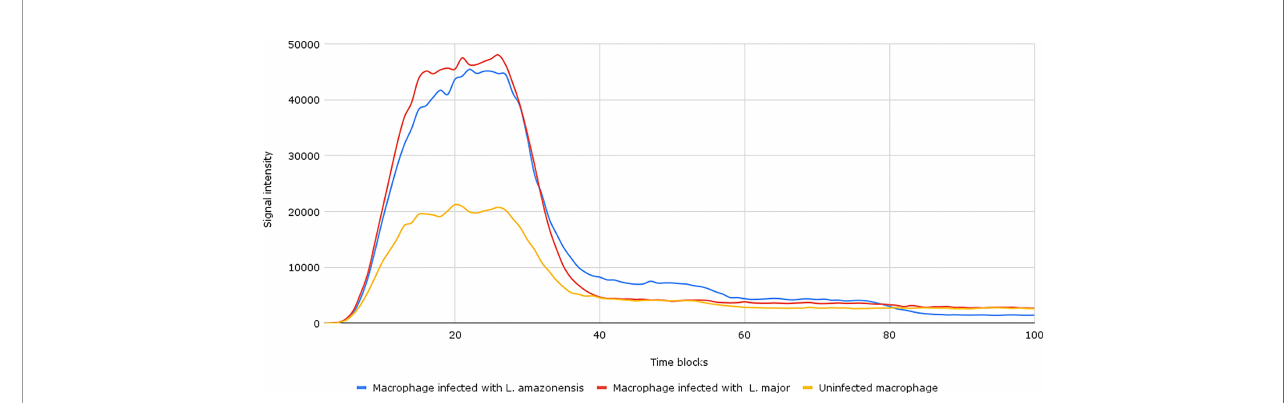
FIGURE 4 | Result of the network simulation with changes in transcription factors. Under normal conditions (uninfected macrophages), as can be seen in yellow lines, the intensity of the fi nal response signal is lower than when compared to infected macrophages with Leishmania major and Leishmania amazonensis represented in red and blue